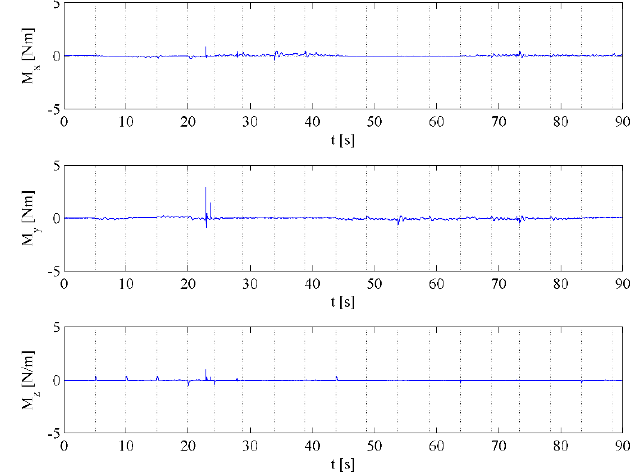
Figure 16. Desired torques of the quadrotor when using the LQR (Linear Quadratic Regulator) controller.